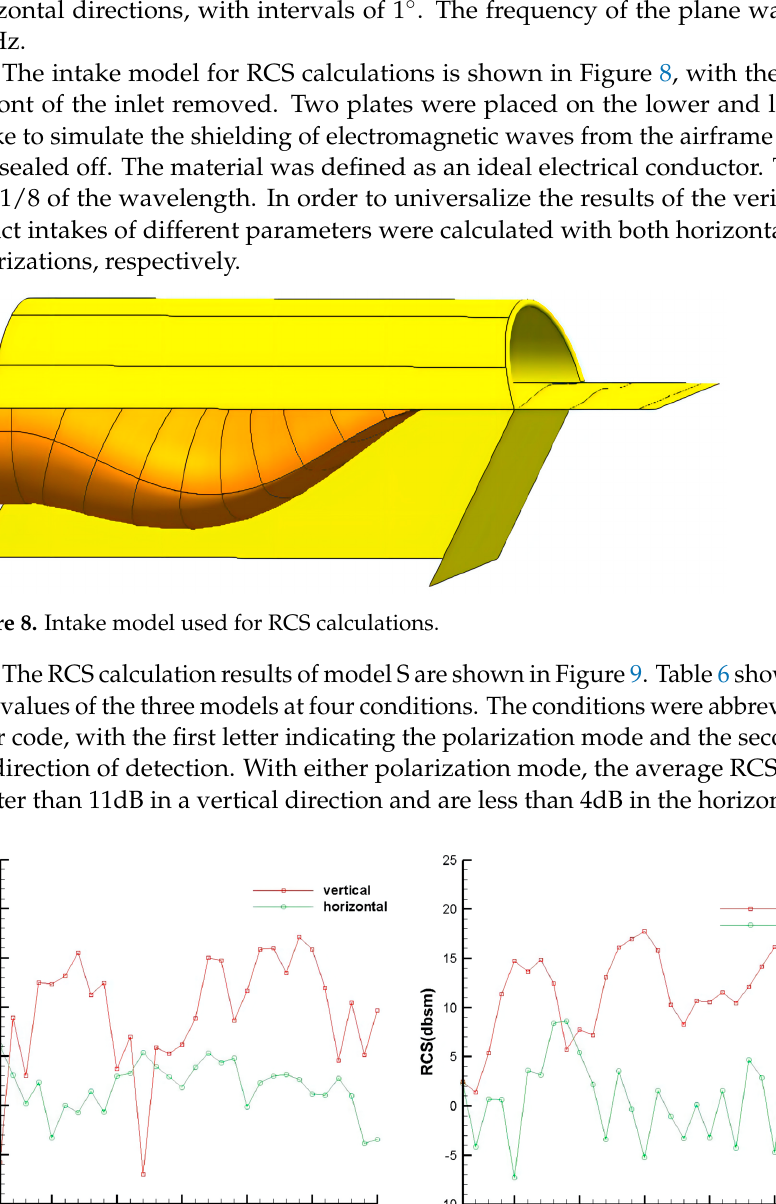
Figure 7. Total pressure distributions at outlet. ( a ) mesh-A (b) mesh-B (c) mesh-C Table 5. Total pressure statistics at outlet.